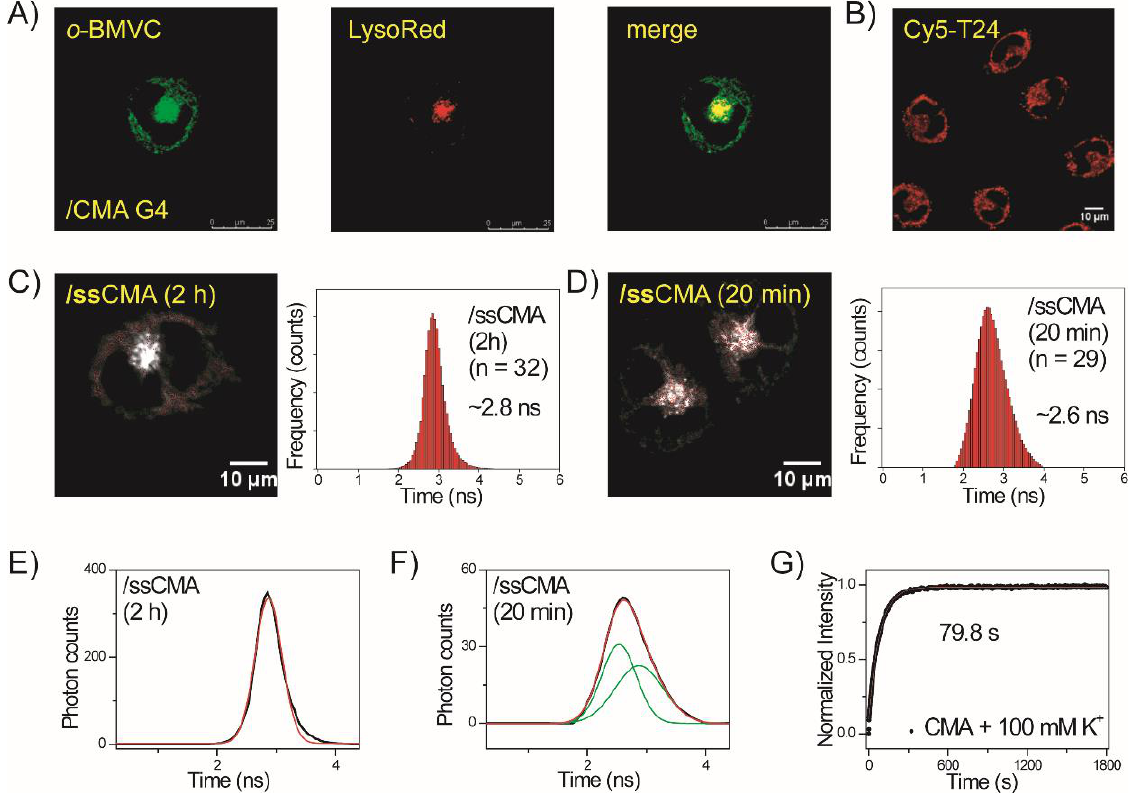
Figure 4. Imaging study of G4 folding of exogenous ssCMA in live cells. ( A ) Confocal images of a mixture of o -BMVC and CMA G4 structures incubated with a CL1-0 cancer cell for 2 h ( left ) and that was then stained with LysoTracker red ( middle ) together with their merges ( right ). ( B ) Confocal image of Cy5-T24 incubated with CL1-0 cancer cells for 2 h. The time-gated FLIM images of a mixture of 5 µ M o -BMVC and 15 µ M ssCMA incubated with live CL1-0 cells for ( C ) 2 h and ( D ) 20 min to study G4 formation together with a histogram of the o -BMVC decay times. ( E ) A curve fitting by a single band at 2.87 ns for the incubation of ssCMA for 2 h and ( F ) a curve fitting by two bands at 2.53 ns and 2.87 ns for the incubation of ssCMA for 20 min. ( G ) The CD signals at 265 nm are a function of time to study G4 formation of ssCMA after the addition of 100 mM K + in